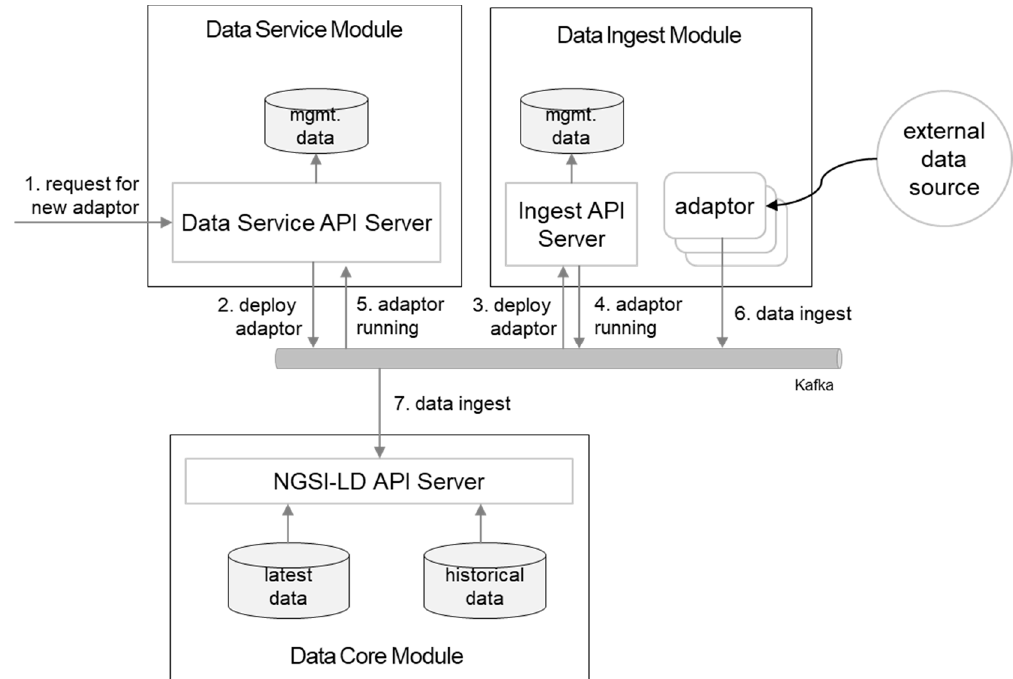
Figure 6. Dynamic ingest adaptor allocation for a new dataset.